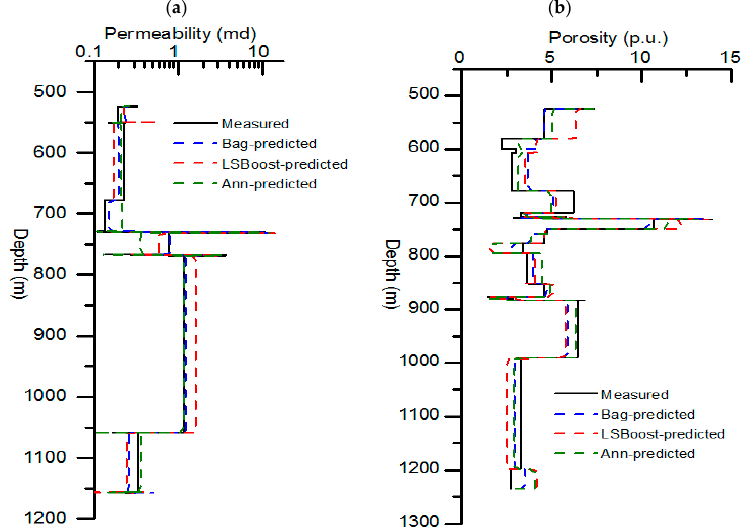
Figure 19. Measured (black), Bag-predicted (blue), LSBoost-predicted (red), and deep learning- predicted (green) curves of permeability ( a ) and porosity ( b ) in the unconventional coal reservoir. The stepped representation provides the comparison among the average permeability at different sections of the well, i.e., low permeable and highly permeable sections. As mentioned earlier, throughout the modeling procedure, porosity was used as the benchmark to guarantee the reliability of the models. Figure 20 represents the 3D porosity cube around one of the subject wells estimated using the statistical Bag ensemble which